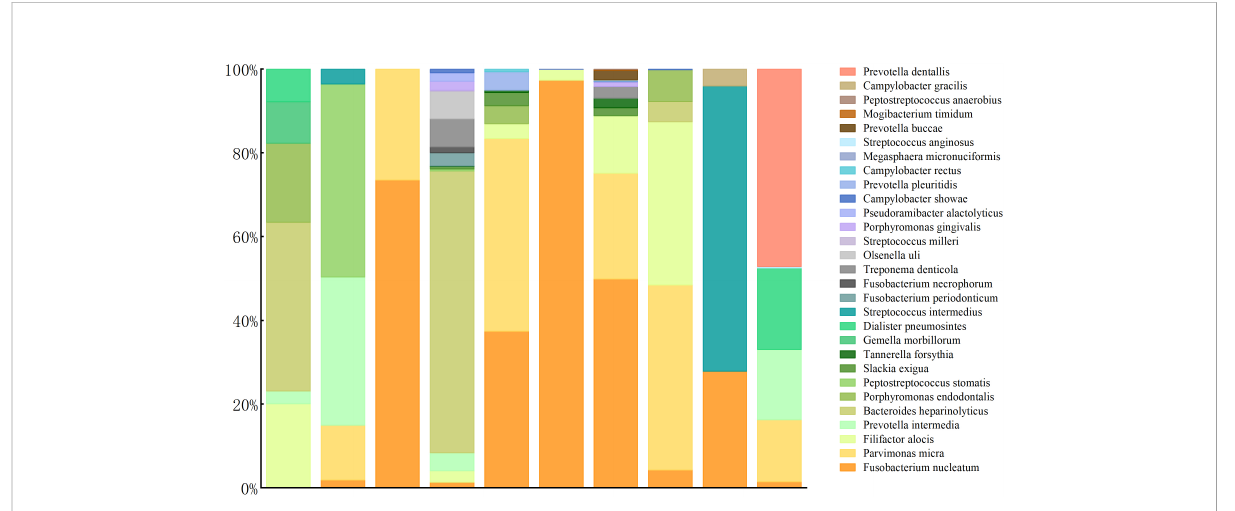
FIGURE 2 Species distribution and relative abundance of pathogens detected by pleural effusion